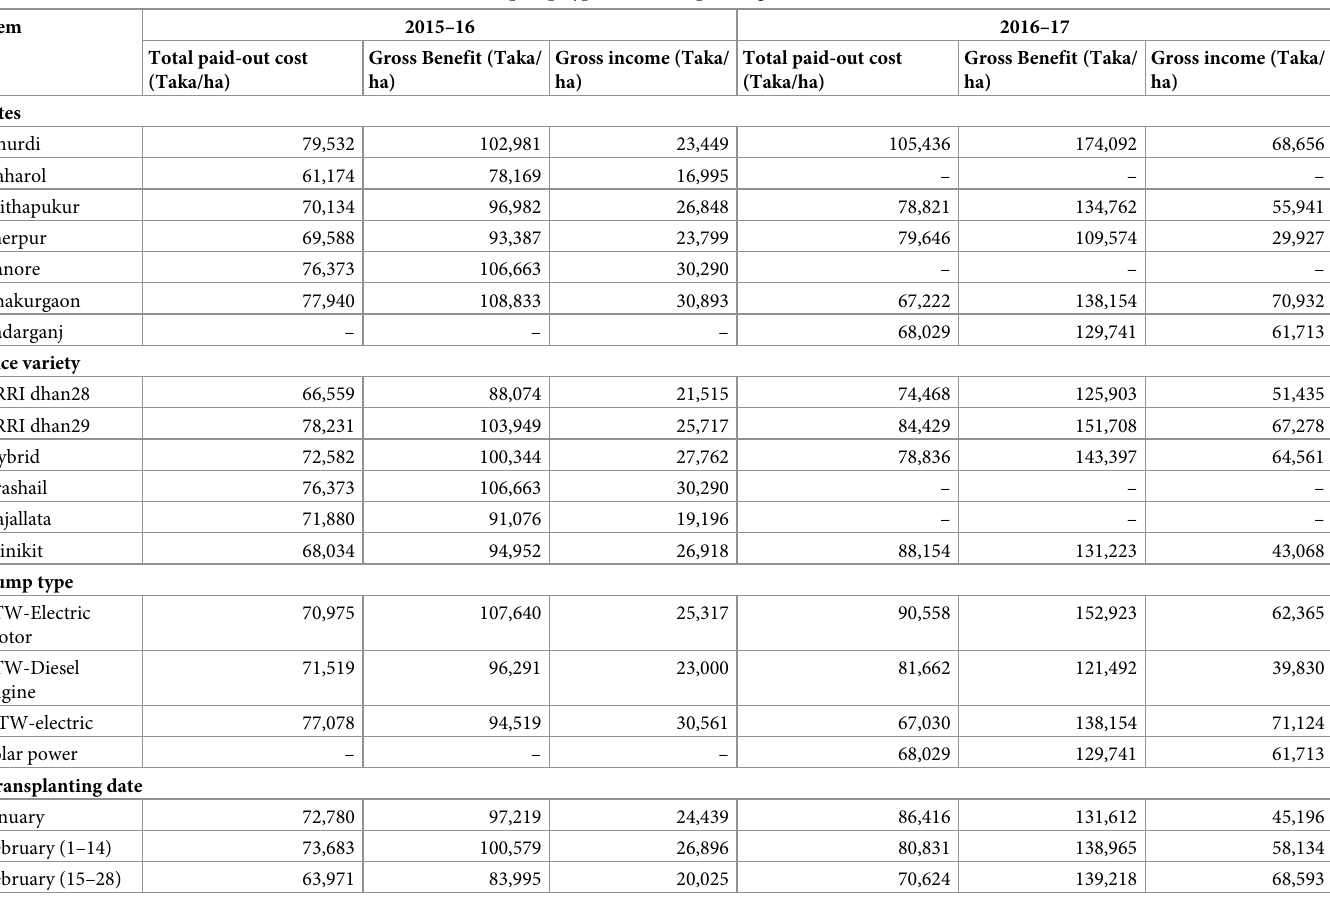
Table 5. Cost and return of Boro rice across sites, rice varieties, pump-types, and transplanting dates.